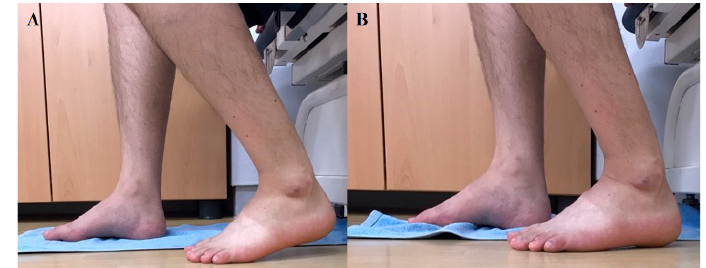
Figure 3. Short foot exercise: ( A ) start, ( B ) end.